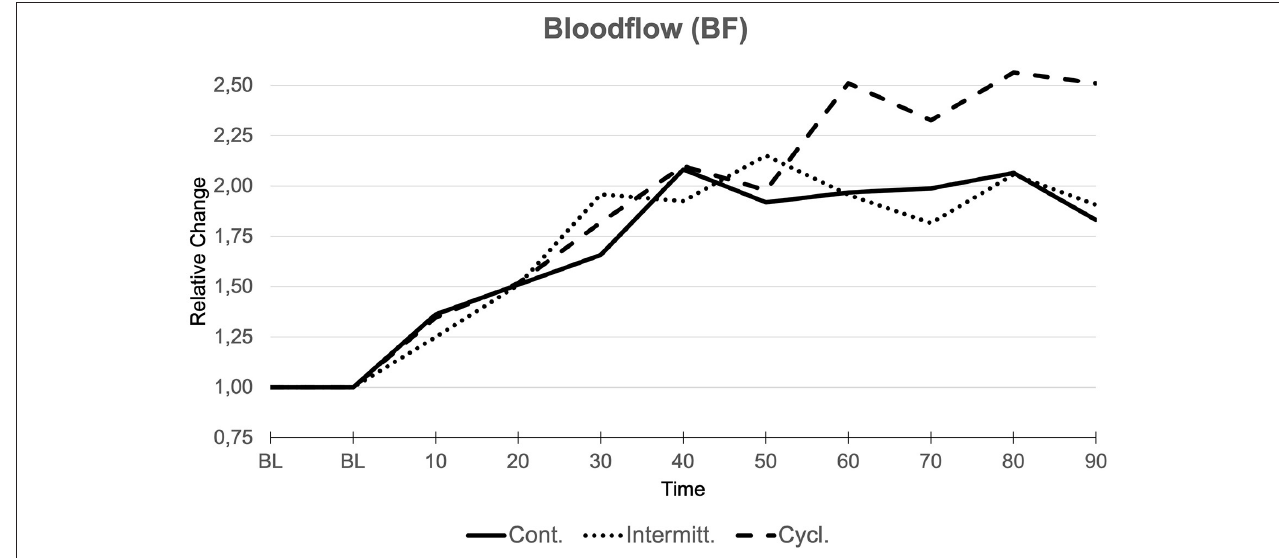
FIGURE 2 | Bloodflow (BF). Relative changes compared to baseline values (BL, 1.000) over the course of measurements (min) in all three groups.